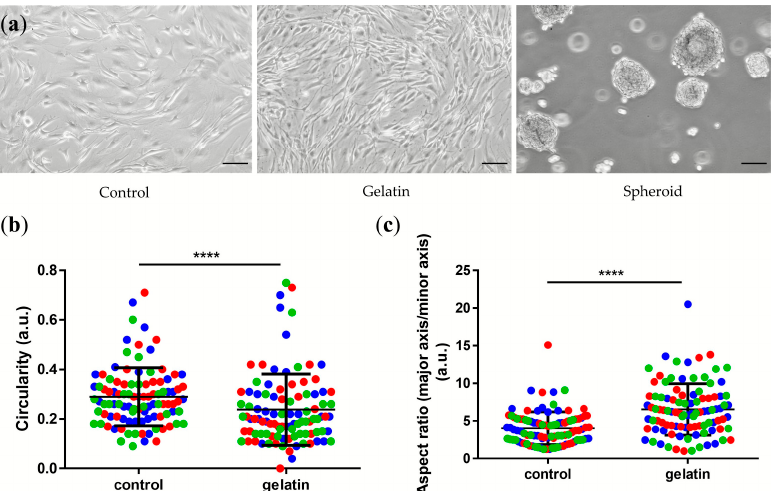
Figure 1. ( a ) Phase-contrast microscopy pictures of NPCs grown on three di ff erent surfaces. Scale bar = 100 µ m. Here, “Control” represents cells cultured in “classic” T75 flasks, “Gelatin” refers to cells cultured in 0.1% gelatin-coated T75 flasks, and “Spheroid” refers to cells from the spheroid formed assay in ultra-low attachment T75 flasks; “a.u.” refers to arbitrary units. Scale bar = 100 µ m. ( b ) Circularity and ( c ) aspect ratio (major axis / minor axis) was measured using imageJ software between control and gelatin groups. In ( b , c ), each dot represents one cell (n = 100), taken from three di ff erent donors and marked in red, green, and blue for both groups respectively, Mann–Whitney U test, **** = p < 0.0001. Lines represent means ± standard deviation